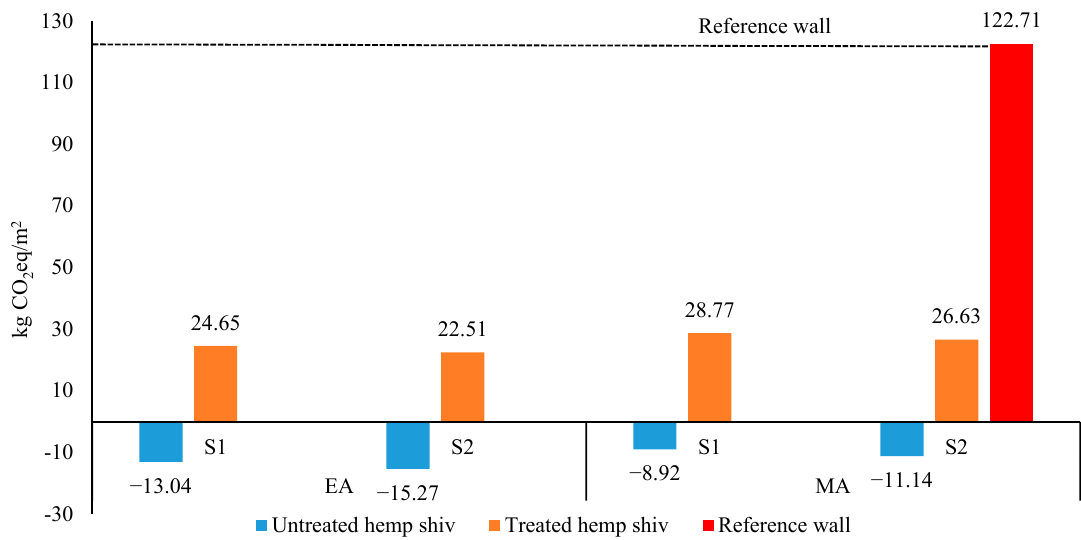
Figure 5. Carbon footprint of 1 m 2 walls for their entire service life. EA and MA show the results based on economic and mass allocation. S1 and S2 are waste scenarios (S1—composting hemp shiv and landfilling the rest, S2—landfilling all the materials).